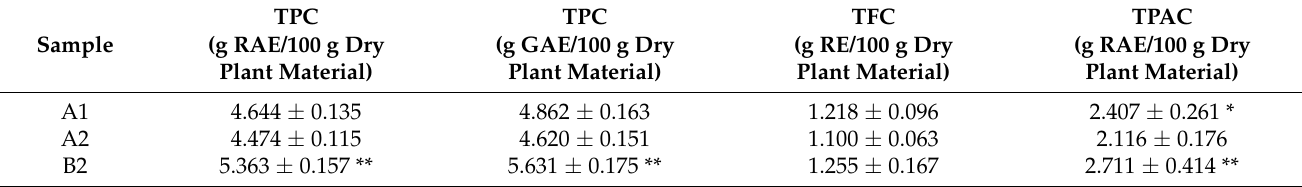
Table 1. Total polyphenolic, flavonoid, and phenolic acid content of D. moldavica samples.